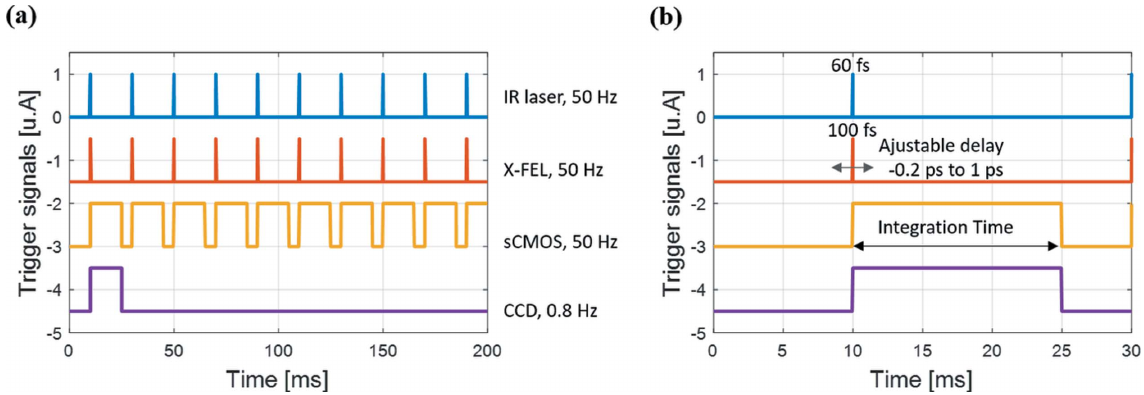
Figure 3 Timing diagram, at larger ( a ) and smaller ( b ) time scales, of the image acquisition signals. Every signal is synchronized with the FEL. The delay of the IR pump pulse is adjustable. Every diffraction peak produced by a FEL probe pulse can be collected with the CMOS camera, whereas only 1 pulse out of 63 can be recorded with a conventional CCD